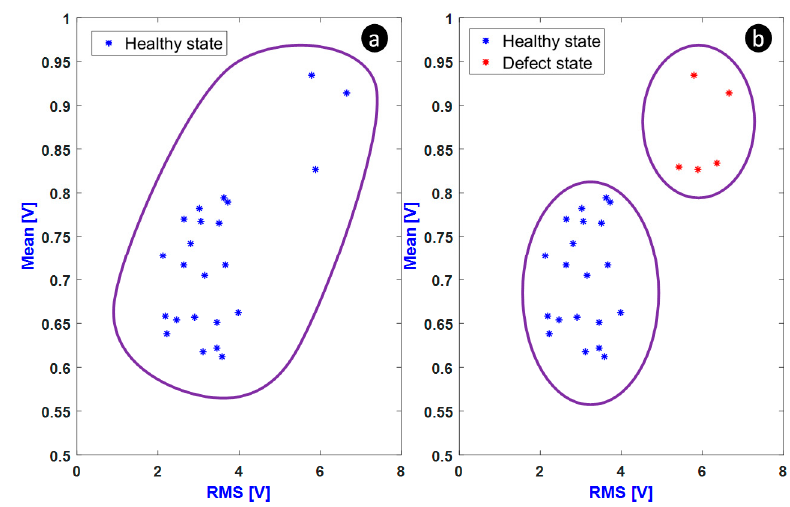
Figure 14. Incrementation of number of clusters (a) k = 1 and (b) k = 2.